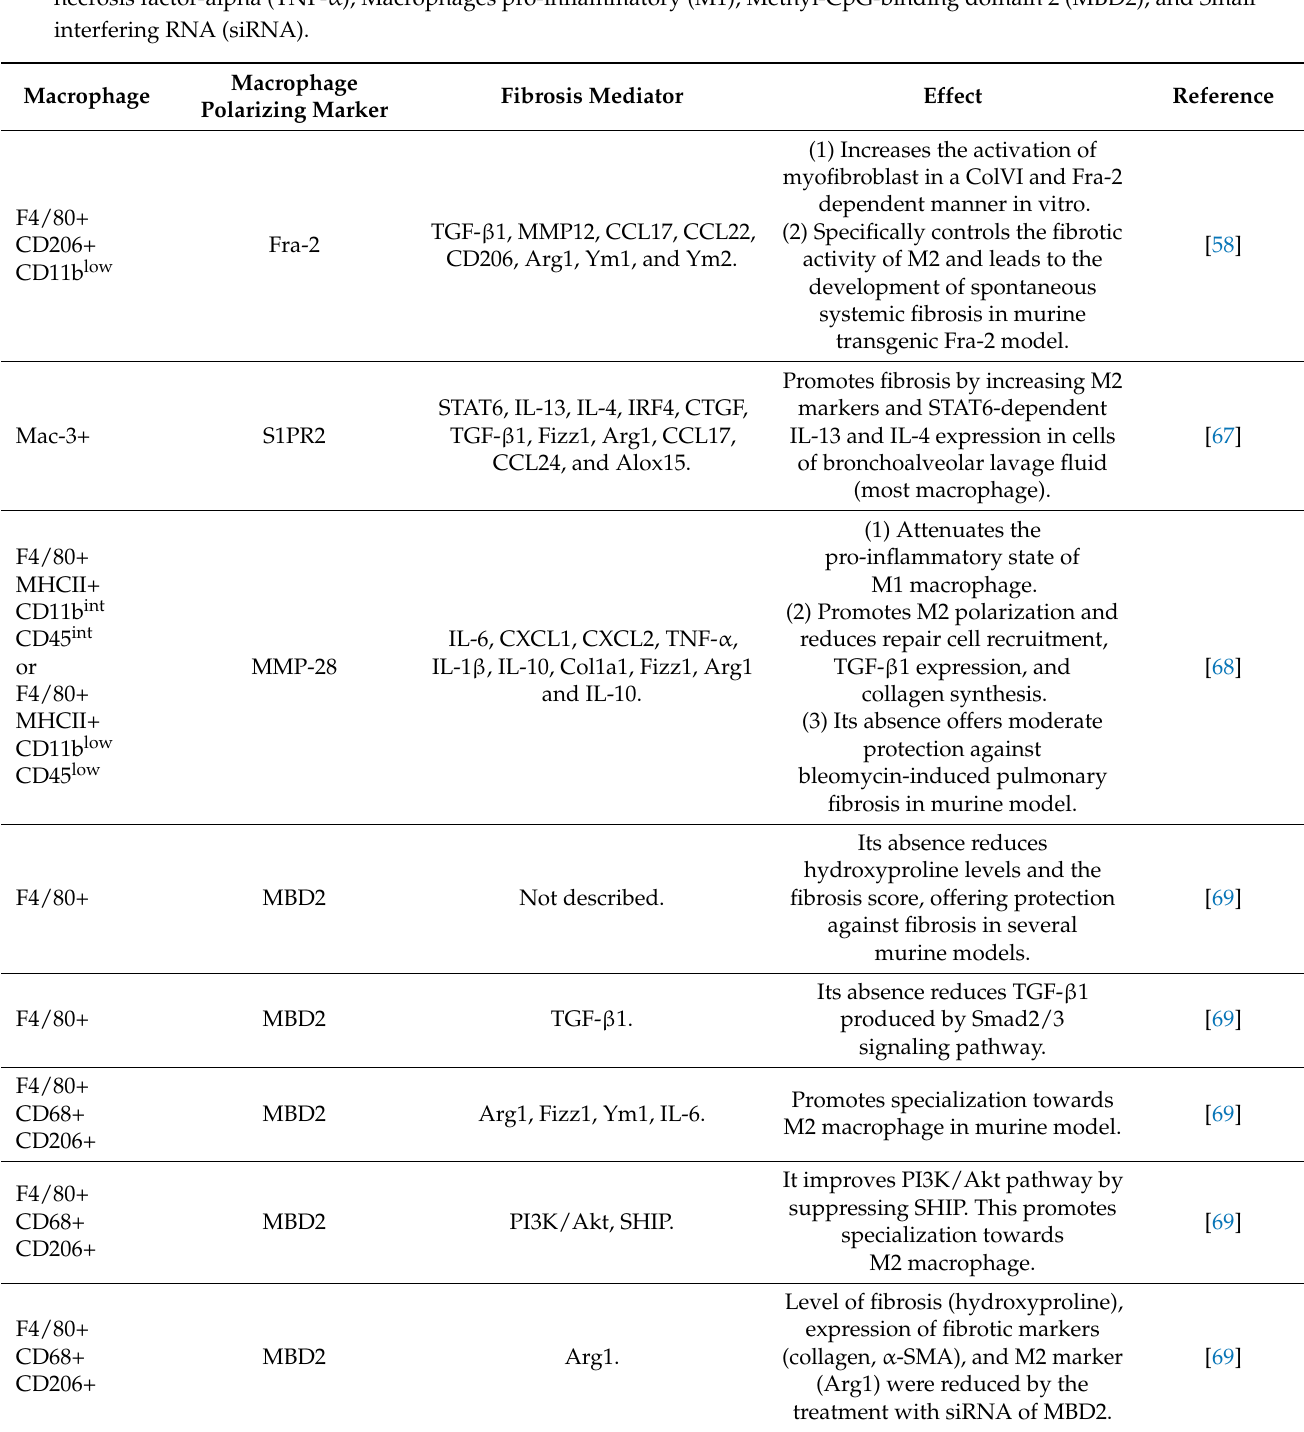
Table 1. Table summarizing how and which types of macrophages are involved in pulmonary fibrosis. Cluster of differentiation (CD), Fos-related antigen-2 (Fra-2), Transforming Growth Factor-beta (TGF- β ), Matrix metalloproteinase (MMP), Chemokine C-C motif ligand (CCL), Mannose receptor 1 (CD206), Arginase 1 (Arg1), Collagen (Col), Macrophage anti-inflammatory/pro-fibrotic (M2), Sphingosine-1-phosphate receptor-2 (S1PR2), Signal transducer and activator of transcription (STAT), Interleukin (IL), Interferon regulatory factor (IRF), Connective tissue growth factor (CTGF), Resistin- like protein α (Fizz1), Class II major histocompatibility complex (MHCII), Chemokine C-X-C motif ligand (CXCL), Tumor necrosis factor-alpha (TNF- α ), Macrophages pro-inflammatory (M1), Methyl-CpG-binding domain 2 (MBD2), and Small interfering RNA